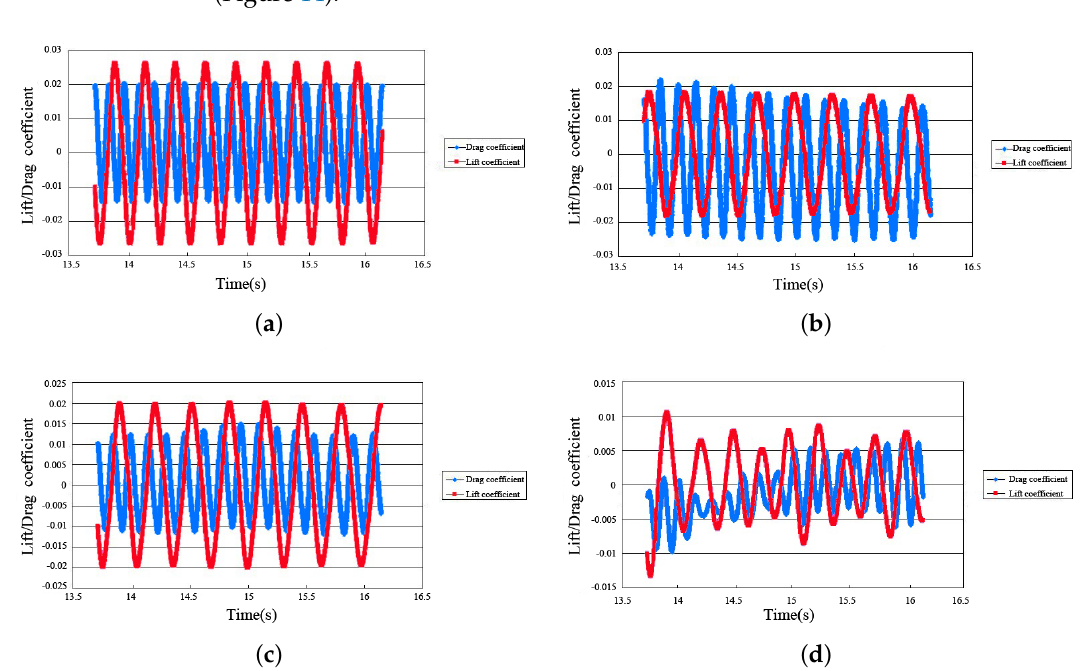
Figure 14. Contrast curves of the vibration periods of lift and drag coefficient at different underwater depths in SCR: ( a ) contrast curve of lift and drag coefficients at 1 m underwater; ( b ) contrast curve of lift and drag coefficients at 2 m underwater; ( c ) contrast curve of lift and drag coefficients at 3 m underwater; ( d ) contrast curve of lift and drag coefficients of the entire